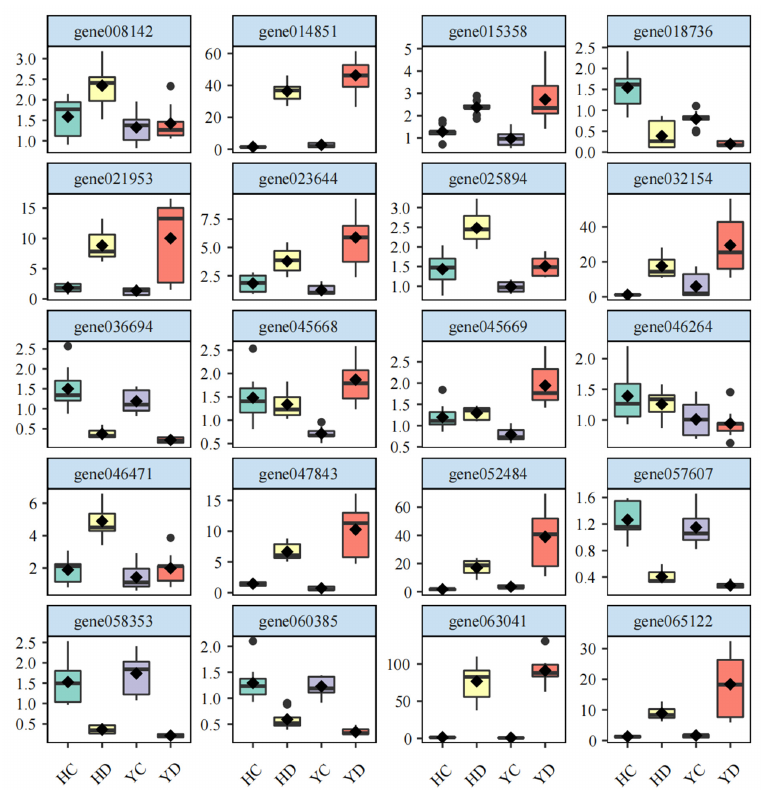
Figure 7. qRT-PCR verification of 16 genes related to key metabolic Figure 7. qRT ‐ PCR verification of 16 genes related to key metabolic pathways.